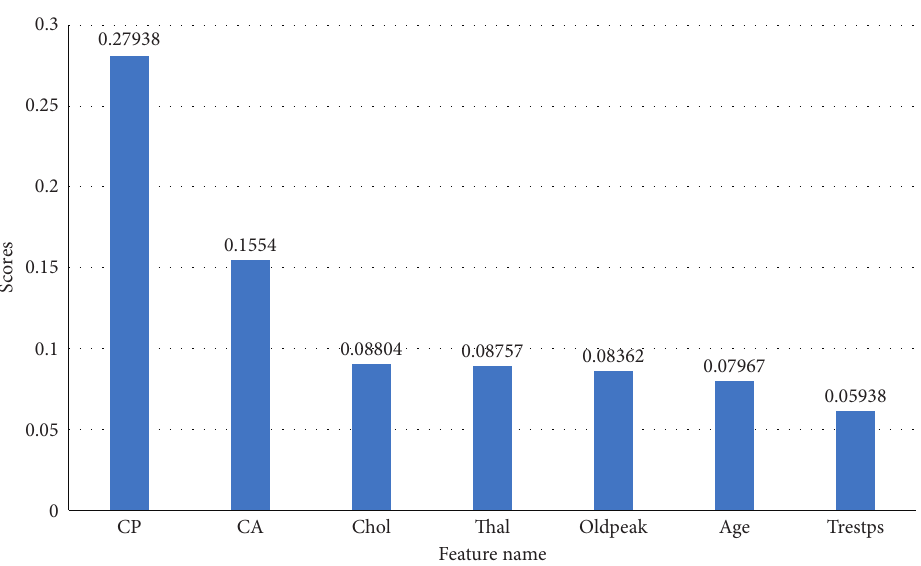
Figure 3: Important features extracted by PCA.